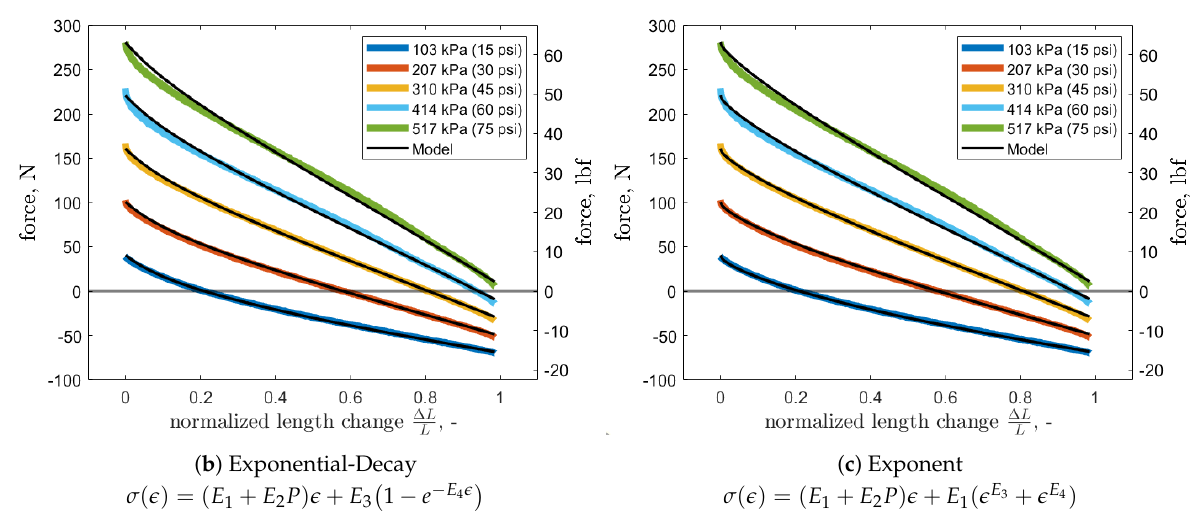
Figure 9. The quasi-static axial force responses of FAM1 extensile fluidic muscles to varying strain for incrementally increasing internal pressure. The axial force outputs of the force-balance model employing the studied stress functions are overlayed as black lines for comparison to experimental data.